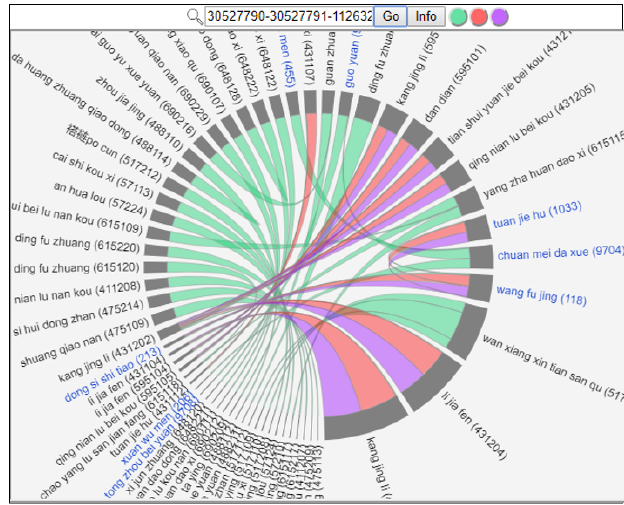
Figure 7. Origin-destination chord view of three